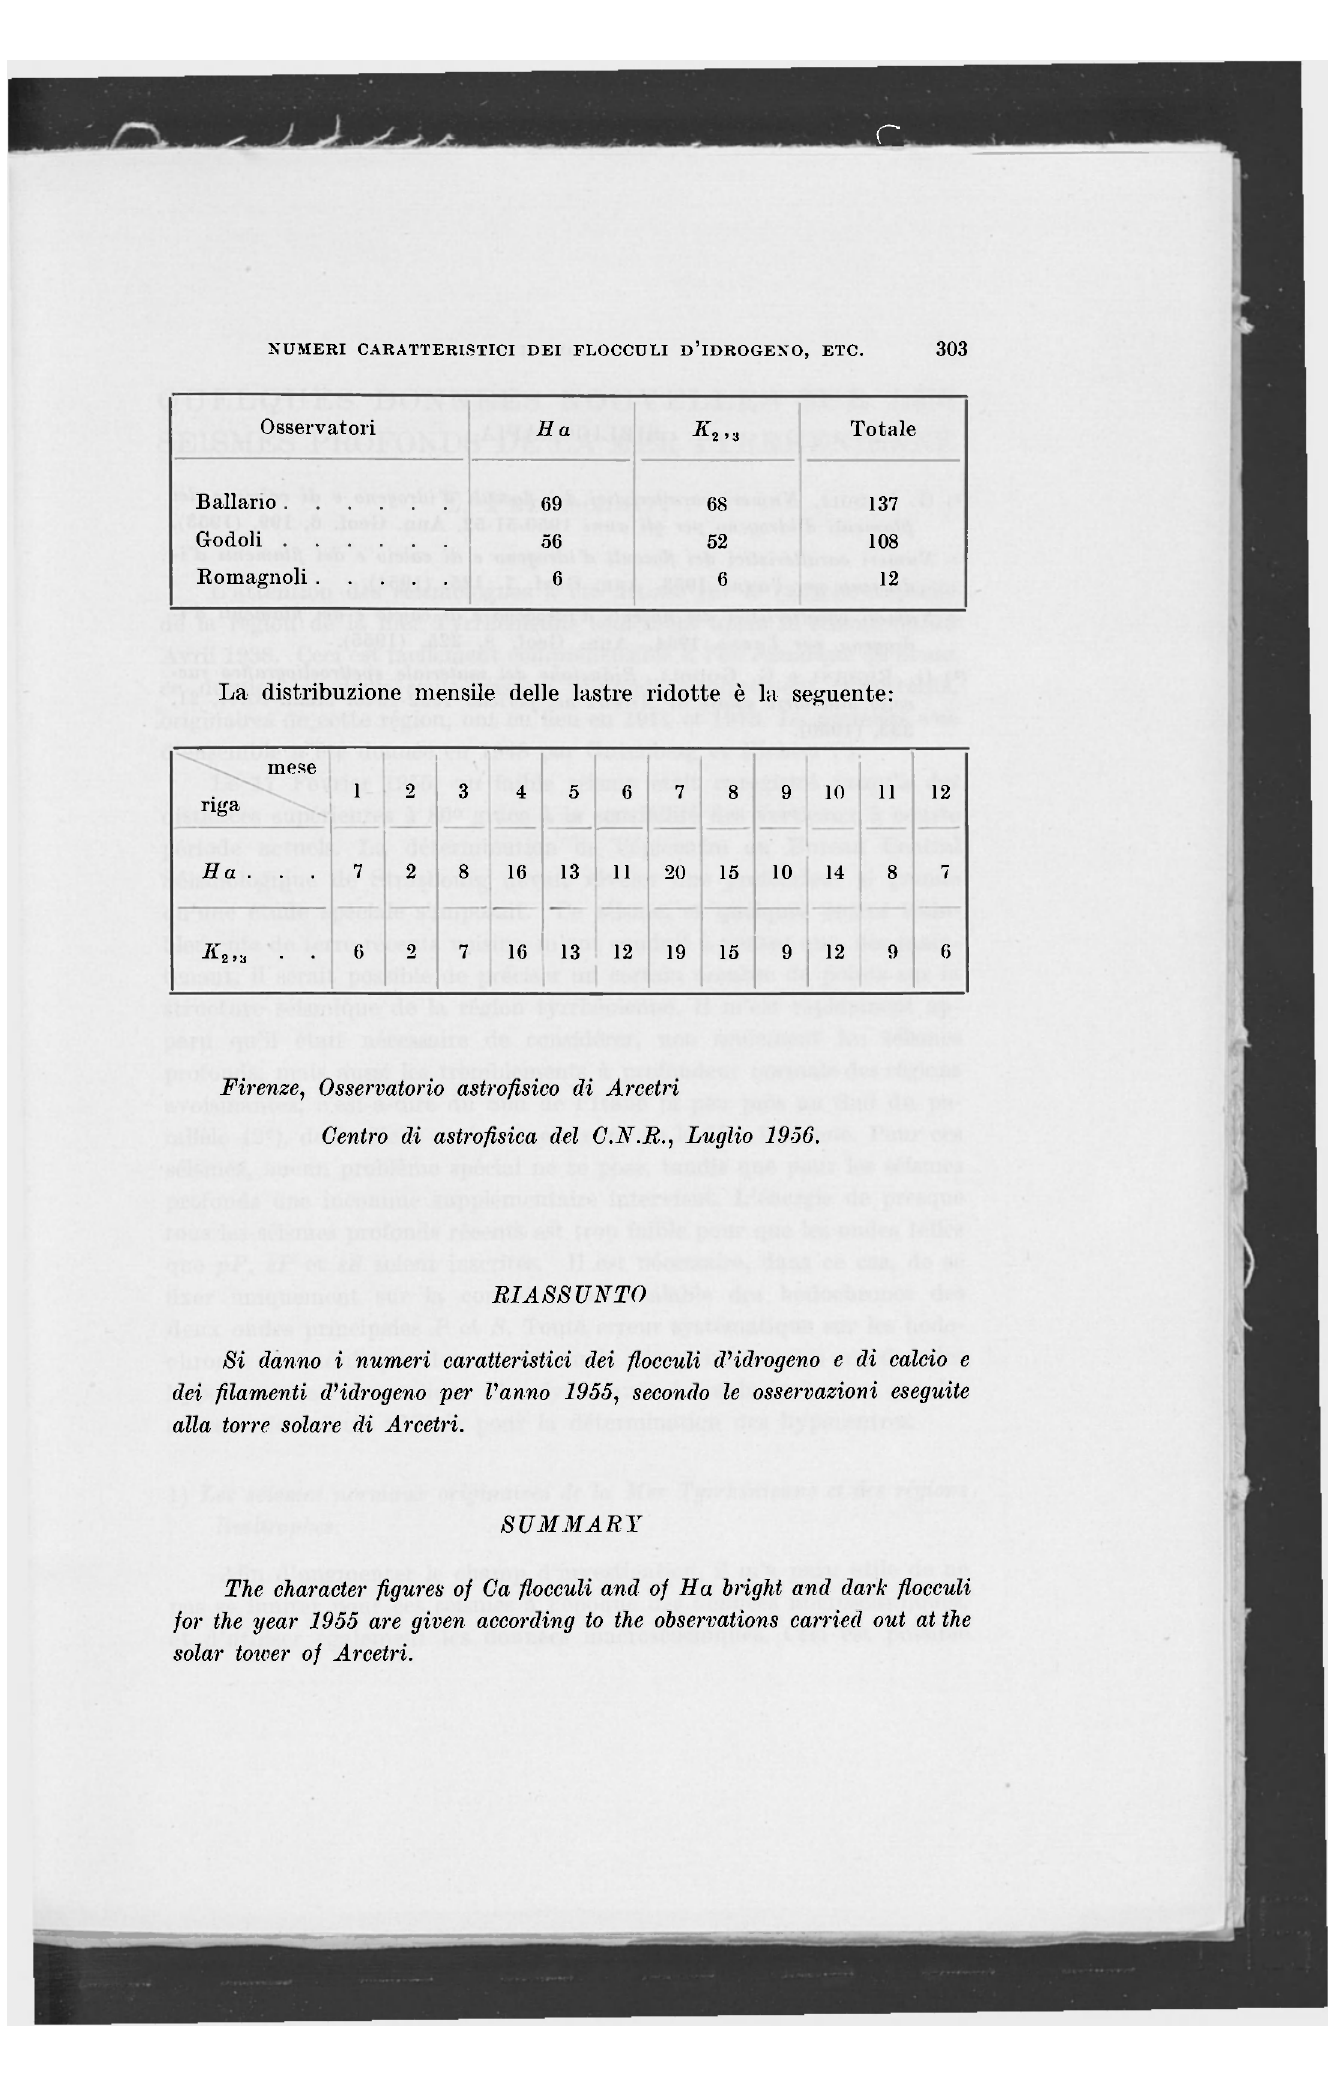
La distribuzione mensile delle lastre ridotte è la seguente: